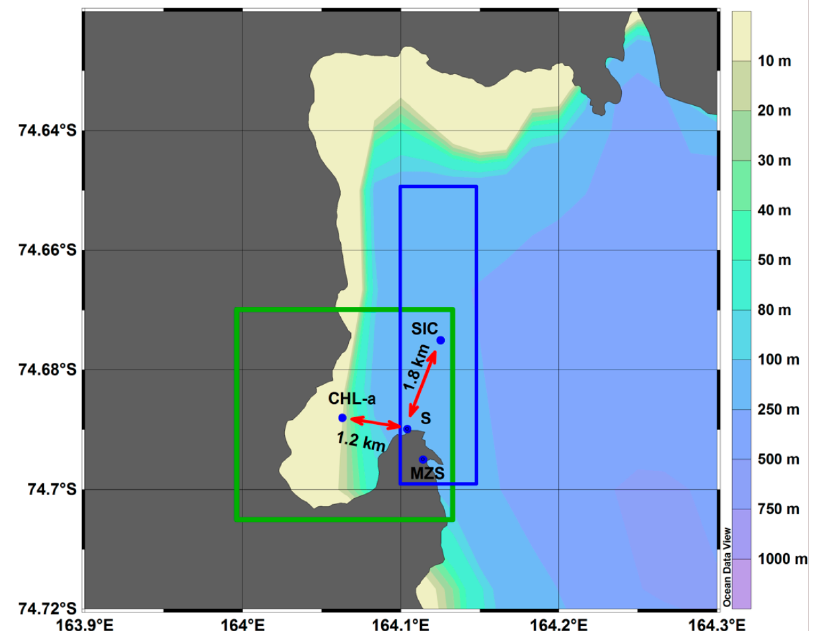
Figure 3. Positions of the experimental site in Thetys Bay (S), Mario Zucchelli Station (MZS), and sea ice concentration ( SIC ) and chlorphyll-a ( Chl -a) satellite data collection points in TNB. The regions of interest for SIC (blue rectangle) and Chl -a (green square) measure 0.05 ◦ × 0.05 ◦ (approx. 1.6 km × 5.6 km) and 4 km × 4 km, respectively. Bathymetry is based on dataset IBCSO v.1.0 (International Bathymetric Chart of the Southern